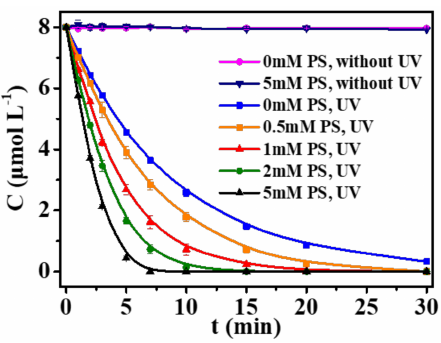
Figure 1. Degradation of p -ASA in different systems. Conditions: ( p -ASA) = 8 µ mol L − 1 , (PS) = 1 mmol L − 1 , (PB) = 20 mmol L − 1 , pH = 6.